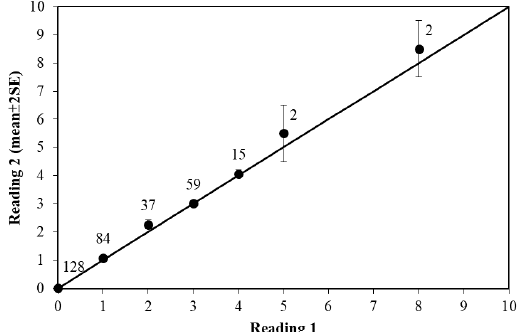
Table 2. Growth parameters of spot-tail sharks estimated from three growth functions.